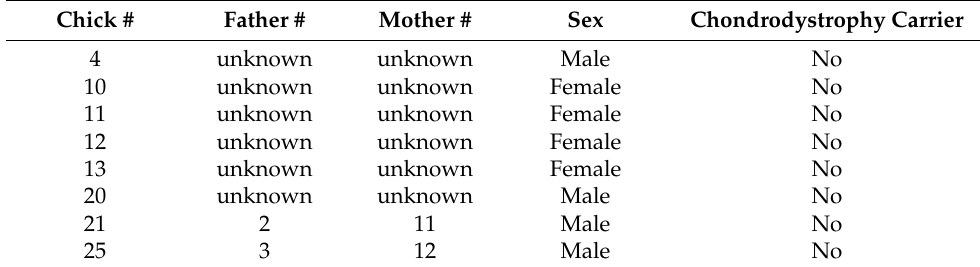
Table 1. A panel of eight individual samples utilized for validating the microsatellite markers. Chick